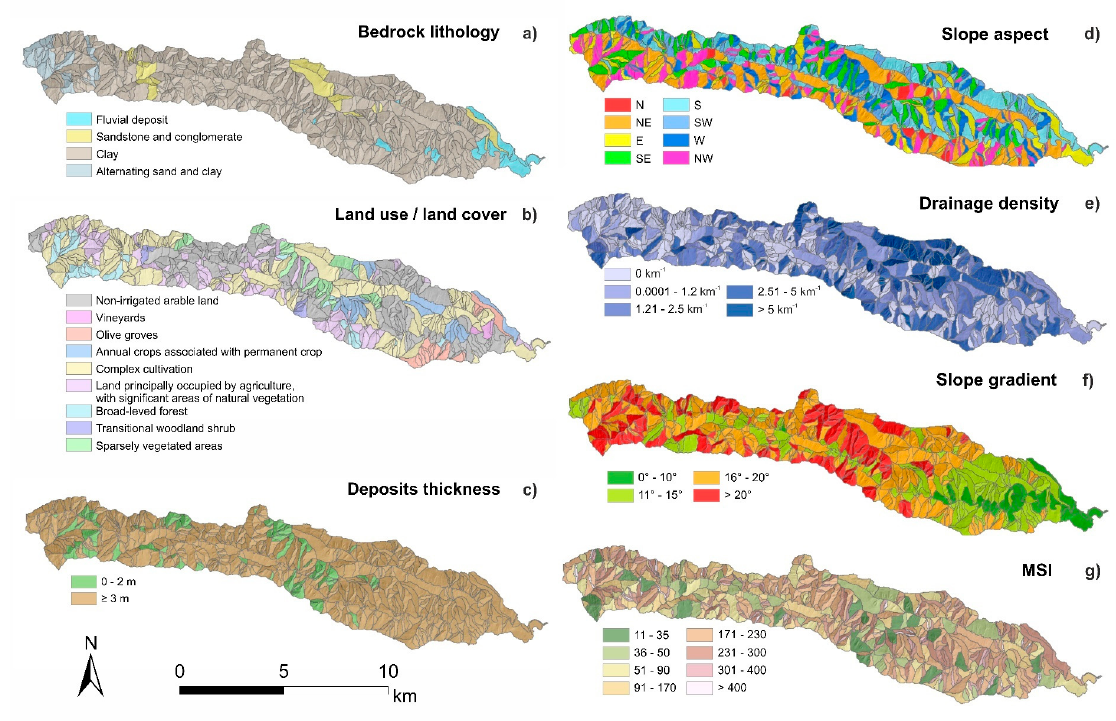
Figure 4. - Schemes of the distribution of the landslide-predisposing factors in the studied basin: ( a ) bedrock lithology derived from field survey; ( b ) land use/land cover derived from the Corine Land Cover maps; ( c ) deposit thickness extrapolated by a linear relation from the slope; ( d ) slope aspect derived from the DEM; ( e ) drainage density derived from the Regional Topographic Maps of Abruzzo Region; ( f ) slope gradient derived from the average slope of the SU; ( g ) MSI calculated from a combination of morphometric features from the